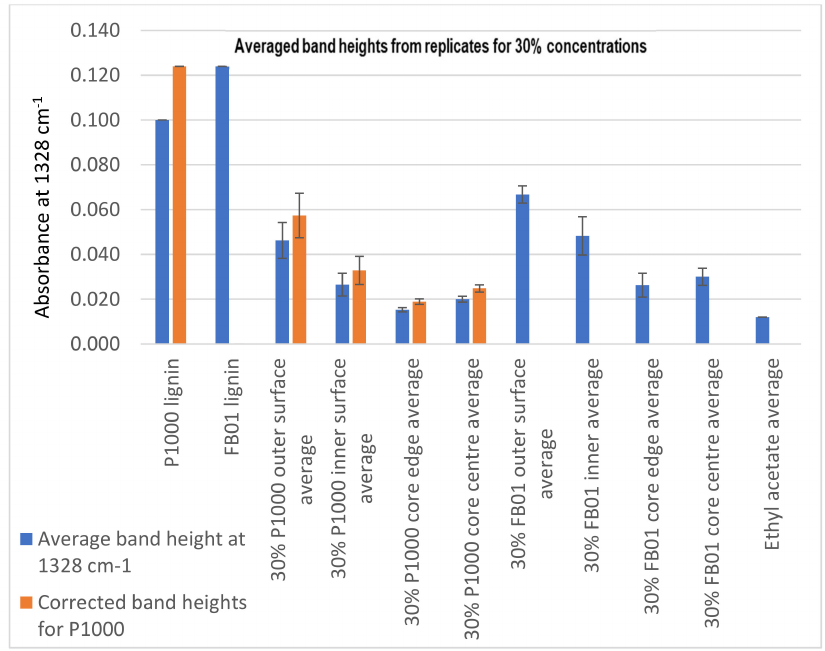
Figure 14. Comparing band heights measured from infrared spectra for 30% concentrations. The band heights from each depth were averaged for each treatment group (4 replicates): ‘outer surface’, ‘inner surface, ‘core edge’ and ‘core